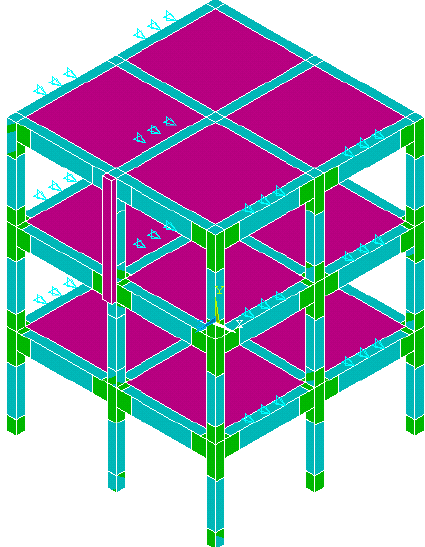
Figure 2. Retrofitted Retrofitted Experimental Model Structure (Altun, 2010) (Altun, 2010) Fig. 2. Retrofitted experimental model structure (Altun, 2010). Figure 3. Finite Element Model of Retrofitted Test Specimen Fig. 3. Finite element model of retrofitted test